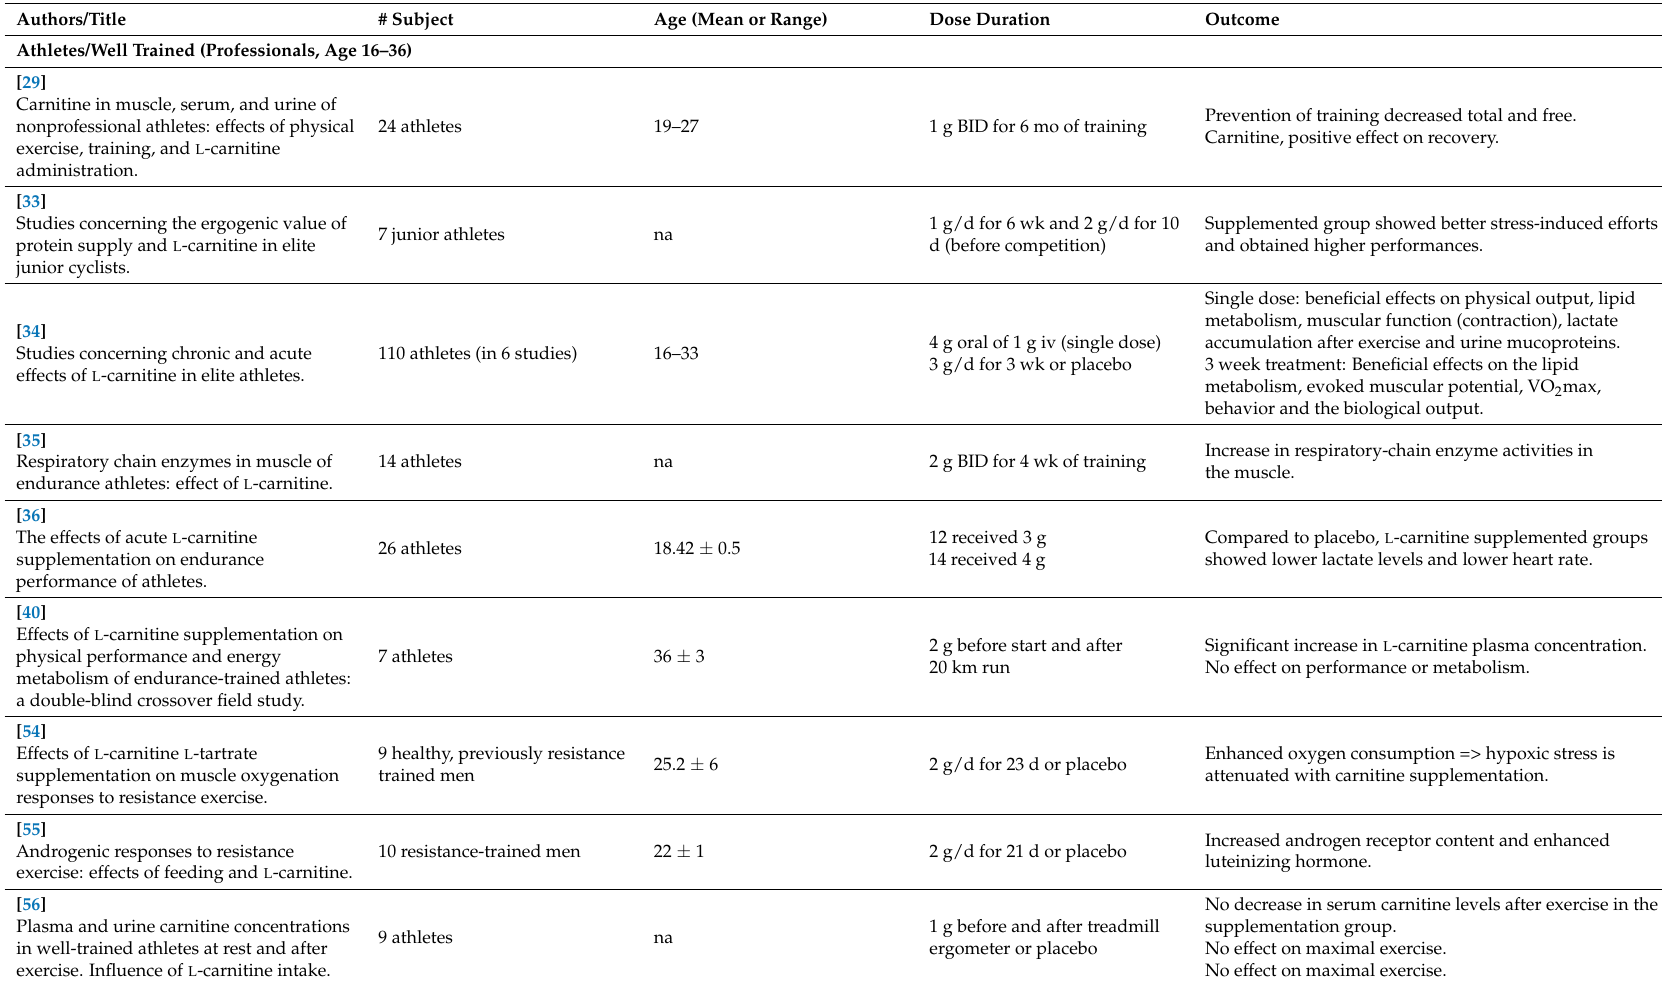
Table 1. Summary of clinical studies investigating the effect of L -carnitine on exercise performance and